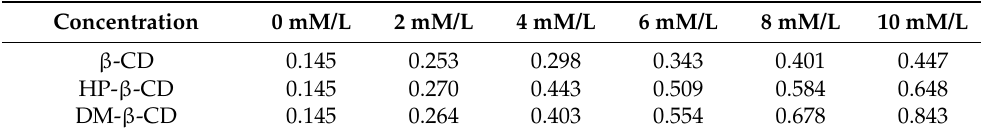
Table 2. Absorbance of rutin aqueous solution with different concentrations of cyclodextrin.